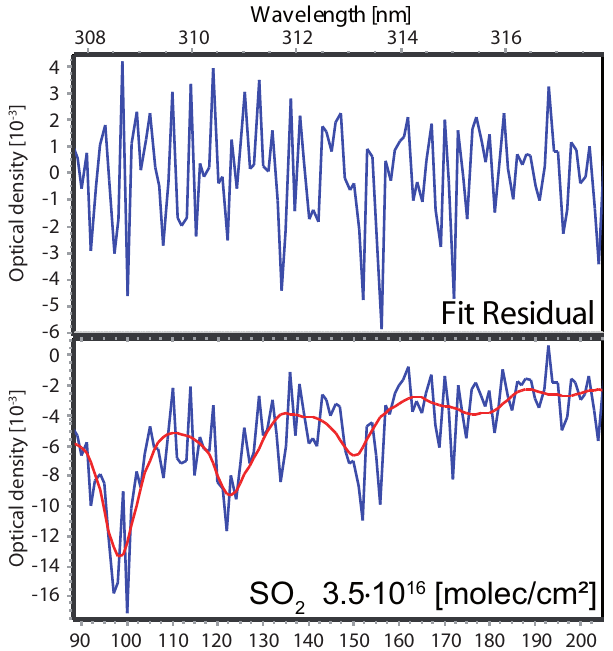
Fig. 7. Fit result for the spectrum gathered at greatest distance (first spectrum of approach IV), taken at 25km distance. Shown is the residual above and the fitted SO 2 SCD of 3 . 5 × 10 16 moleccm − 2 below.